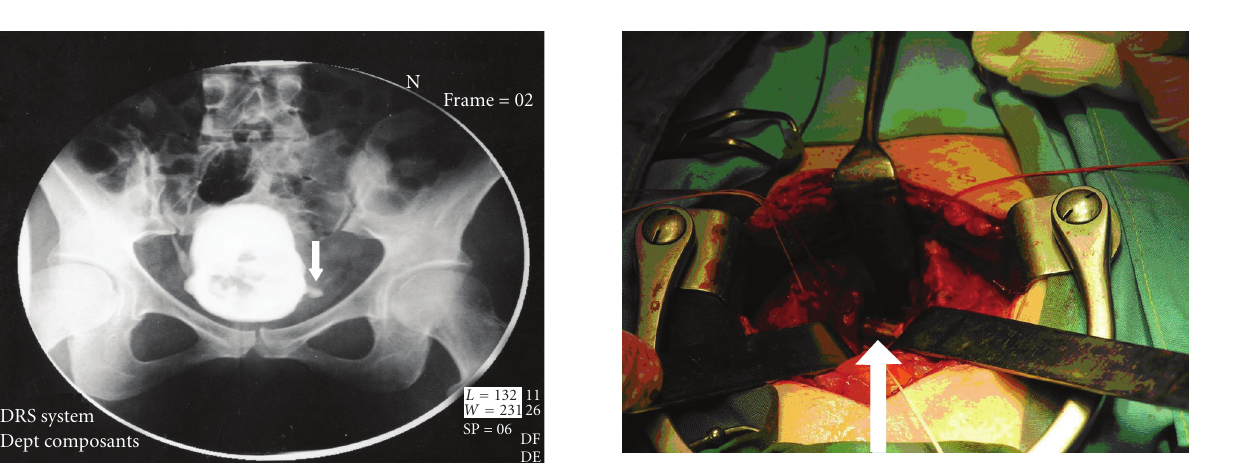
Figure 1: X-ray of bladder: the foreign body penetrate the left wall of bladder.